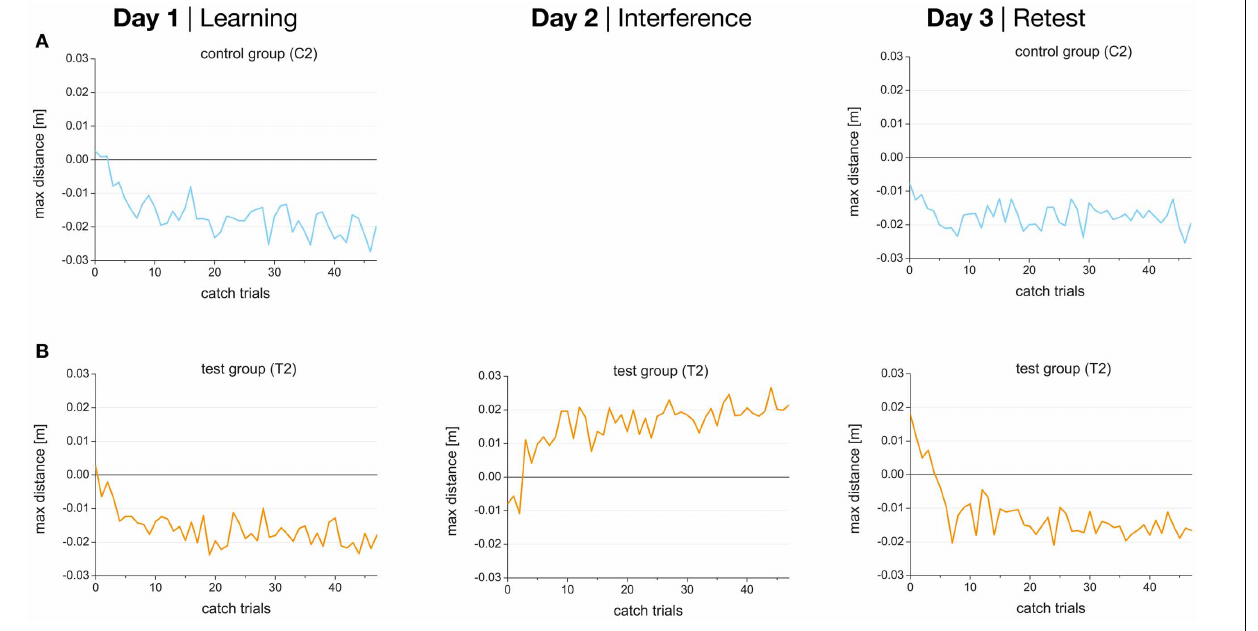
groups (B) separately. Negative values indicate after-effects appropriate to force field A, and positive values indicate after-effects appropriate to force field